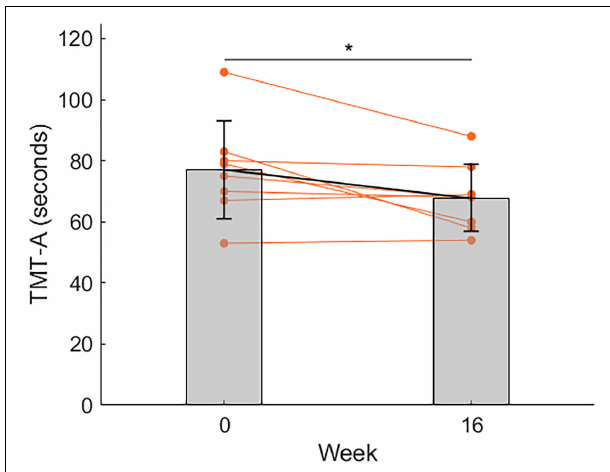
FIGURE 2 | Changes in the reaction time (seconds) of TMT-A. Compared to before the exercise program (week 0), the mean reaction time decreased at week 16. * p < 0.05. Data is shown as mean ± SD. Orange points represent individual